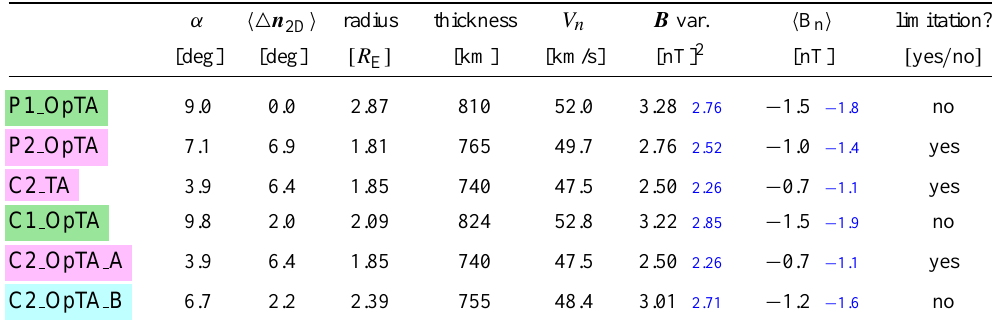
Table 5. MP characteristics for the 24 June 2003 event, based on the valid solutions provided by different implementation of the 2-D, non- planar method. Global values corresponding to MP orientation, radius of curvature, thickness, normal velocity as well as normal magnetic field variance and normal magnetic field component are provided. The last column indicates whether a spatial limitation in the validity range of the corresponding solution is required in order to avoid an artificial return of the first pair of satellites to the MP interior. For the error estimate of the MP radius of curvature, thickness and normal velocity, see Appendix C. α h4 n 2D i radius